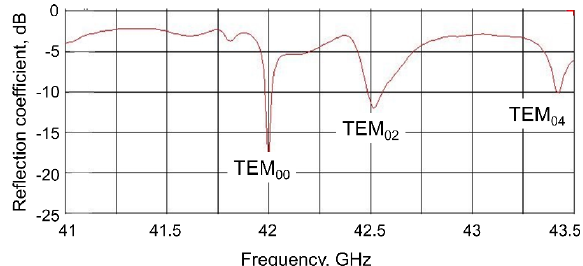
Figure 8. Experimentally measured reflection coefficient of the open resonator connected to the microwave waveguide. The water layer is 50µm thick, the sapphire window is 1.5mm thick, and the separation between mirrors is 2 λ . The different resonance modes are identified by comparison with the CST simulations shown in Fig. 3.